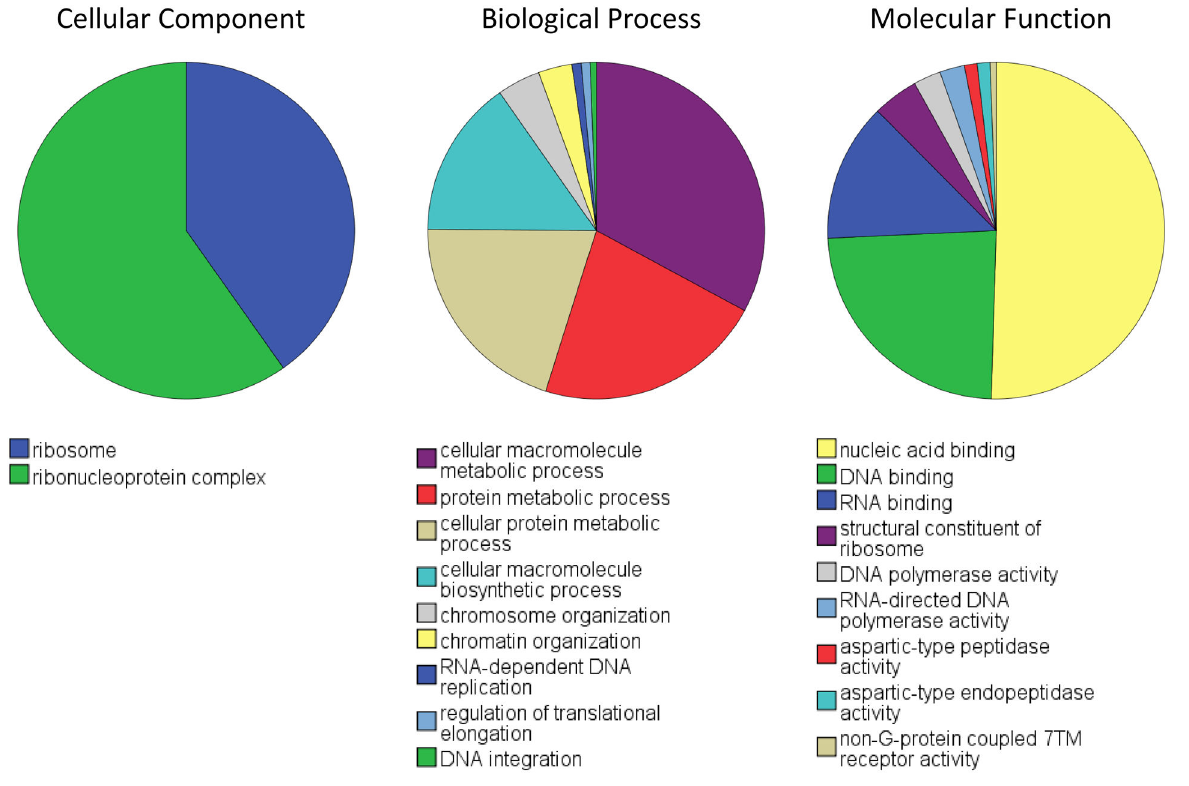
Figure 2. GO terms that are over-represented in the developing eye of the squid versus the developing eye of Nautilus . Results generated using fisher’s exact test corrected with multiple selection between contigs expressed at least two-fold in the squid sample versus the Nautilus